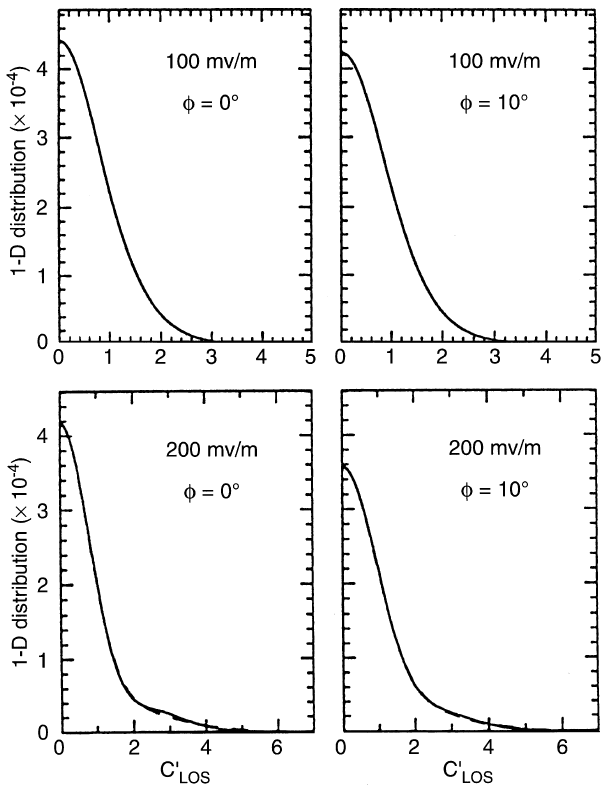
Fig. 2. Two-Maxwellian fitting in dashed line of the original 1-D ion distributions for (cid:117) (cid:136) 0 (cid:14) in the left panels , and (cid:117) (cid:136) 10 (cid:14) in the right panels . The upper panels represent the 100 mV/m case, and the lower panels the 200 mV/m case